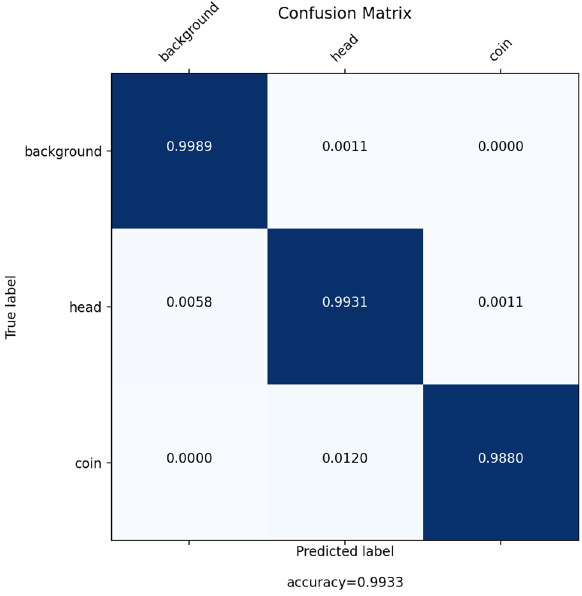
Figure 3. Confusion matrix corresponding to the main semantic segmentation model.